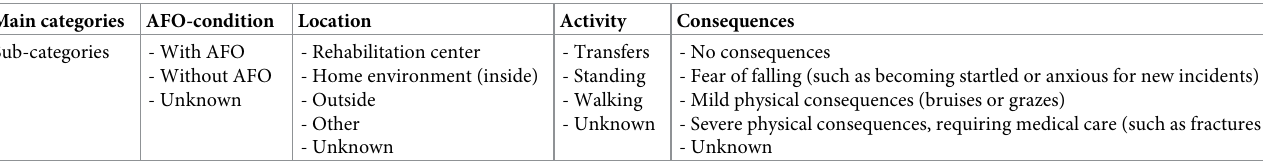
Table 1. Categories used to determine fall and near fall